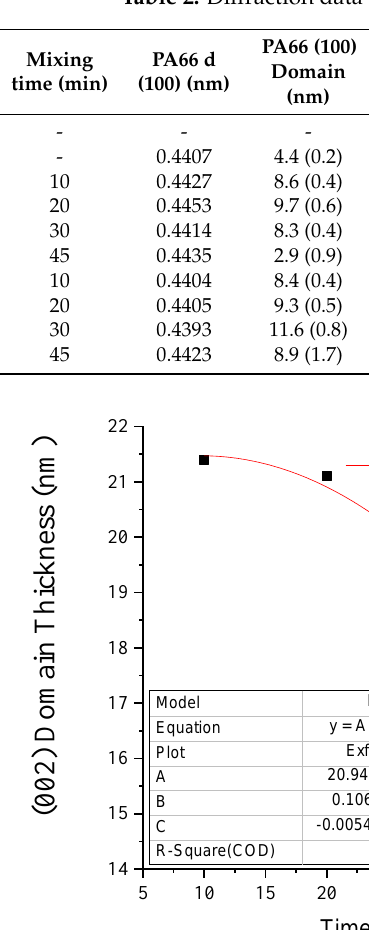
Table 2. Diffraction data for Graphite, PA66 and G-PA66.